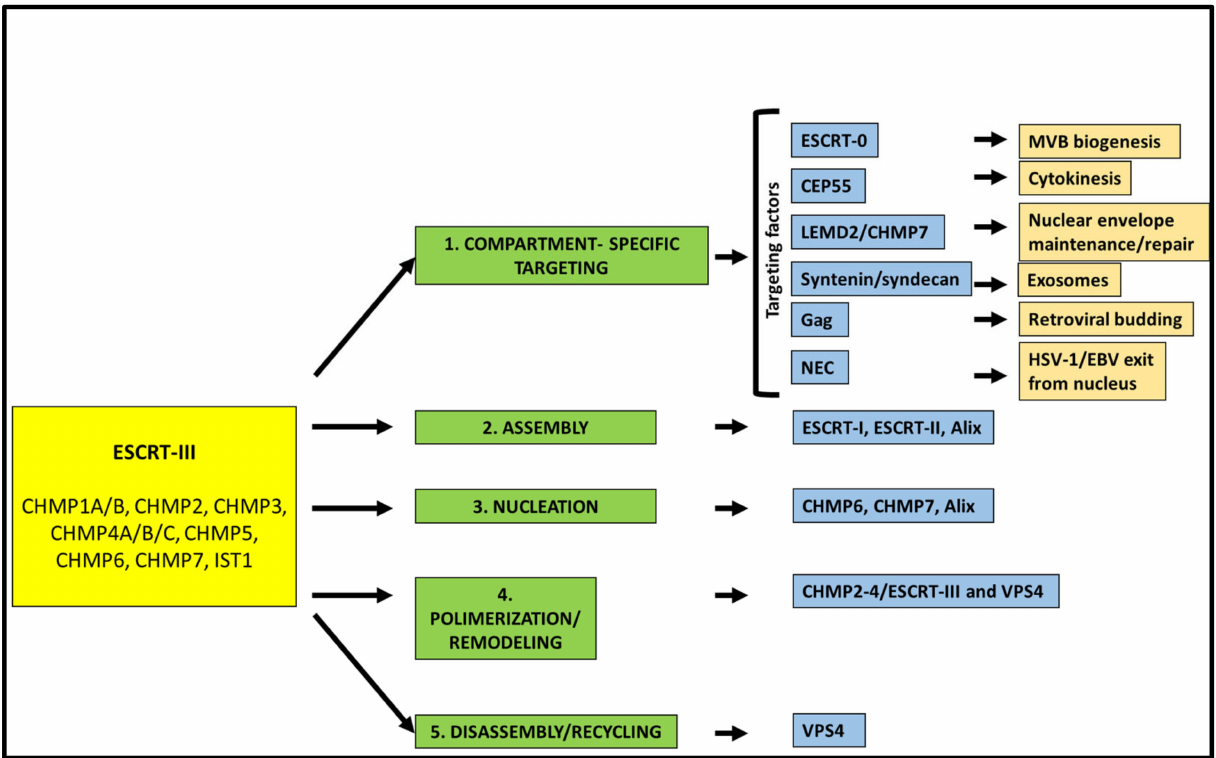
Figure 1. Schematic representation of the sequential steps leading to ESCRT-III polymerization and functioning. The main factors involved in each step are reported, along with the biological processes in which ESCRT-III plays a role based on its compartment-specific recruitment (light orange